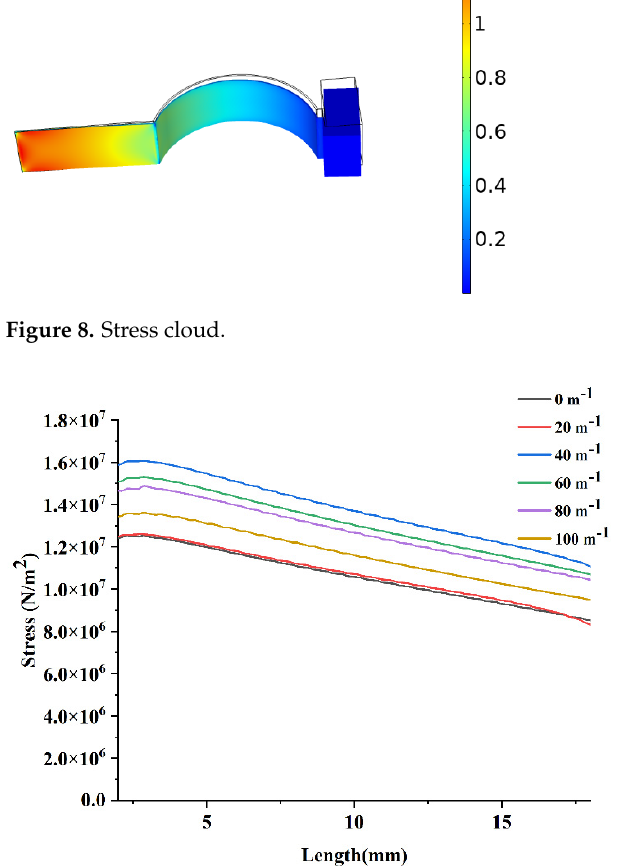
Figure 9. Stress-length diagram of the straight segment.